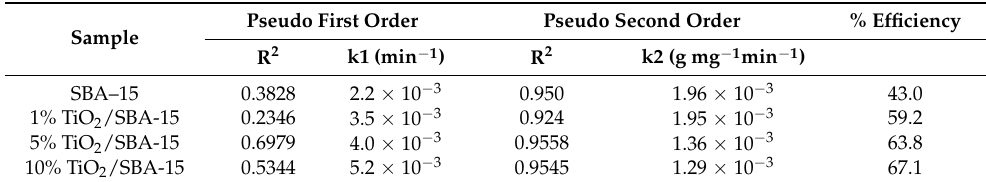
Table 3. Data of kinetics model of Pseudo first order and second order for SBA-15 samples before and after titania